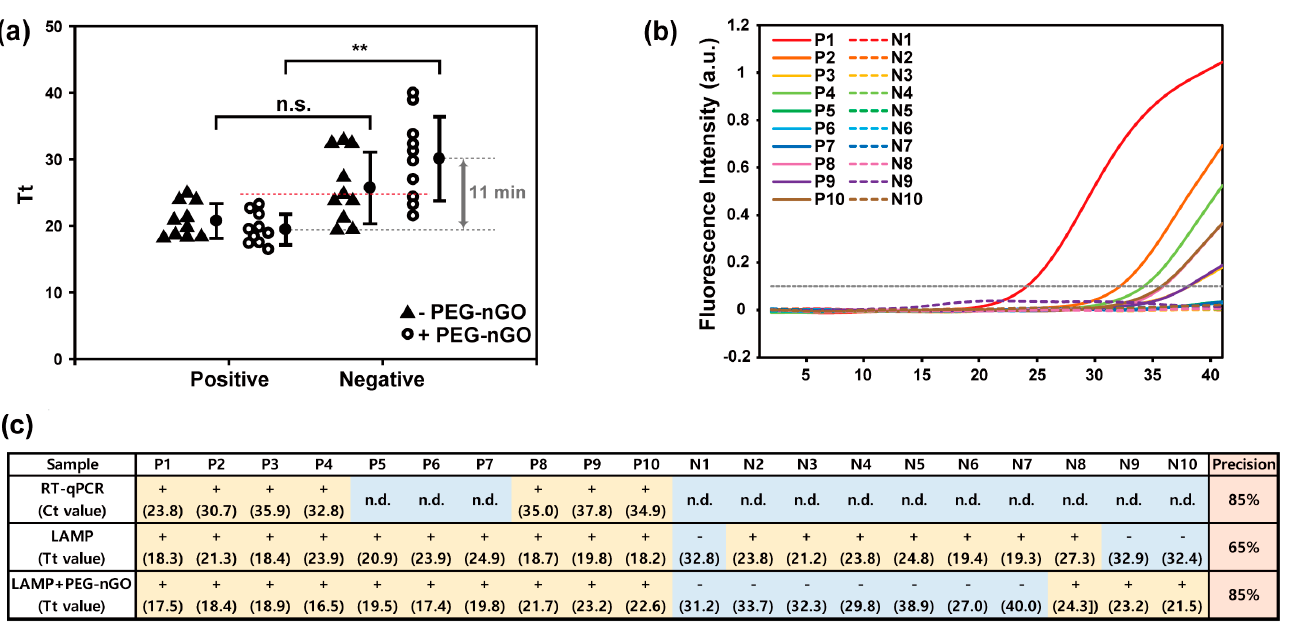
Figure 4. Evaluation of PEG-nGO − based LAMP system for detecting HCV − positive and HCV − negative clinical samples. ( a ) Tt values of 20 HCV clinical samples with 10 positive and 10 negative samples in the presence or absence of PEG-nGO. In conventional LAMP (without PEG-nGO), Tt values are plotted for each positive and negative clinical samples (triangles) and red, dashed line represents the cut − off for decision of positive or negative sample. Tt values are presented as average, and the error bars display the standard deviation, with no statistical significance (n.s., non-specific). In PEG-nGO − based LAMP, Tt values are plotted for each positive and negative clinical samples (circles). Tt values are presented as average, and the error bars display the standard deviation, with statistical significance (**, p < 0.01, positive vs. negative). Tt values of both HCV − positive and HCV − negative samples are plotted based on the real − time fluorescence monitoring of LAMP − amplified products. ( b ) Curves of fluorescence change in conventional RT − qPCR analysis with a total of 20 HCV clinical samples including HCV − positive (solid line) and negative samples (dashed line). ( c ) Table shows a comparison of analysis results acquired from the RT − qPCR, conventional LAMP, and PEG-nGO − based LAMP method for 20 HCV clinical samples. All 10 HCV − positive samples are detected as positive in PEG-nGO − based LAMP, while 7 out of 10 samples are found positive in qRT − PCR. Inversely, 3 and 7 out of 10 negative samples are detected as negative in conventional LAMP and PEG-nGO − based LAMP, respectively. Abbreviation: +: detected as positive based on cycle threshold (Ct) or Tt; -: detected as negative based on Ct or Tt; n.d.: non-detected.